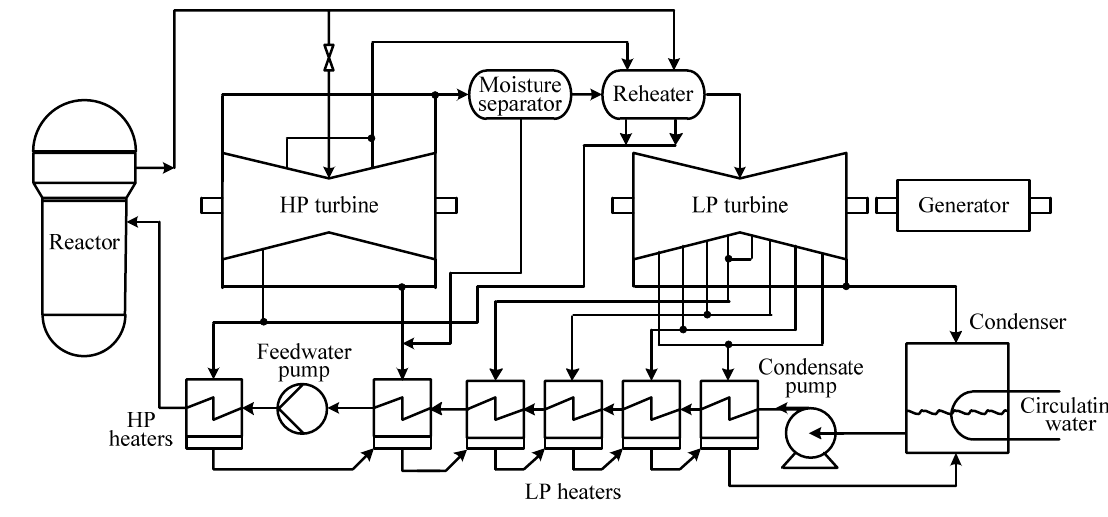
Figure 1. Simplified schematics of the overall BWR nuclear power